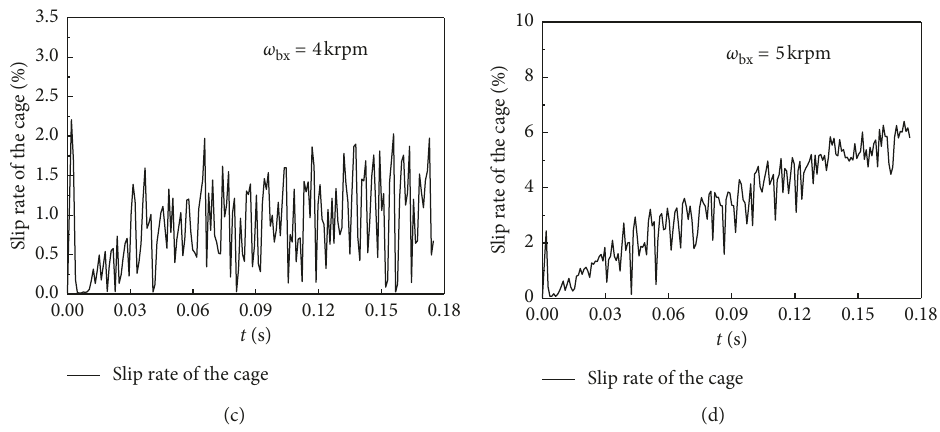
Figure 9: The slip rate of the cage. F